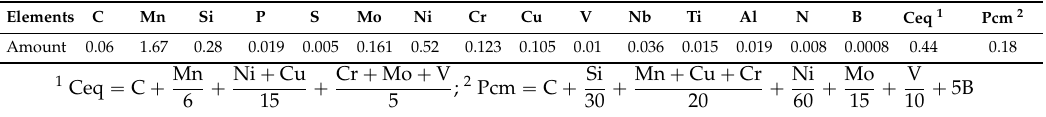
Figure 1. Schematic diagram for sampling method of the impact specimens (WZ: weld zone; HAZ: heat affected zone; BM: base metal). Table 1. Chemical compositions of the weld metal (wt. %). Table 1. Chemical compositions of the weld metal (wt. %).